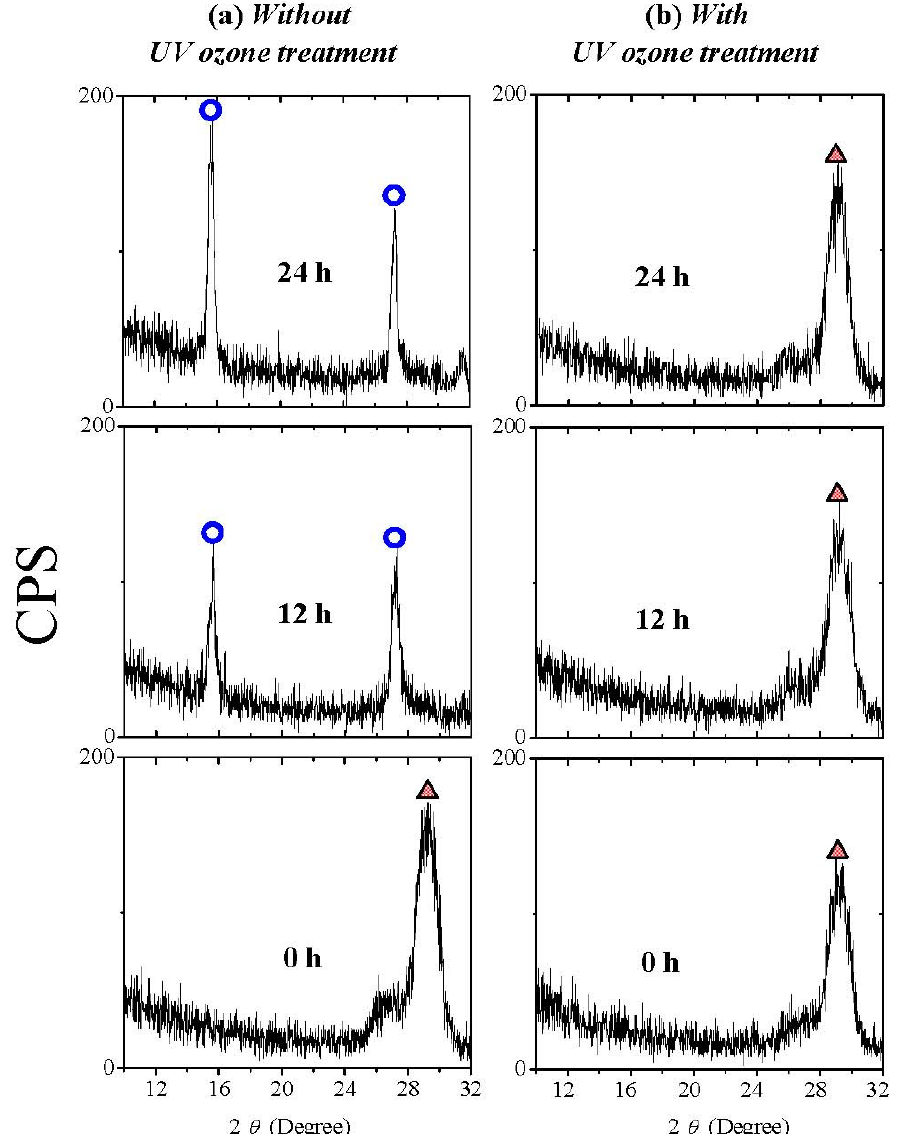
Figure 9. XRD patterns of La O films ( a ) with and ( b ) without UV ozone post treatment 2 3 after N annealing. Films were exposed to air (Temperature 25 °C and relative humidity 2 about 25% respectively) for different